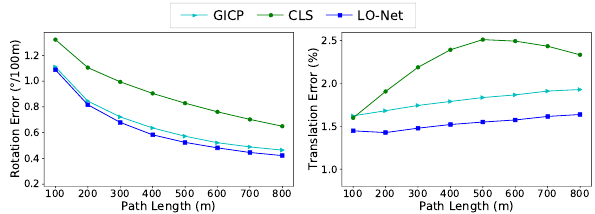
Figure 4. Trajectory plots of KITTI Seq. 08 with ground truth. The results of ICP-po2po are not shown as its large scale drift.